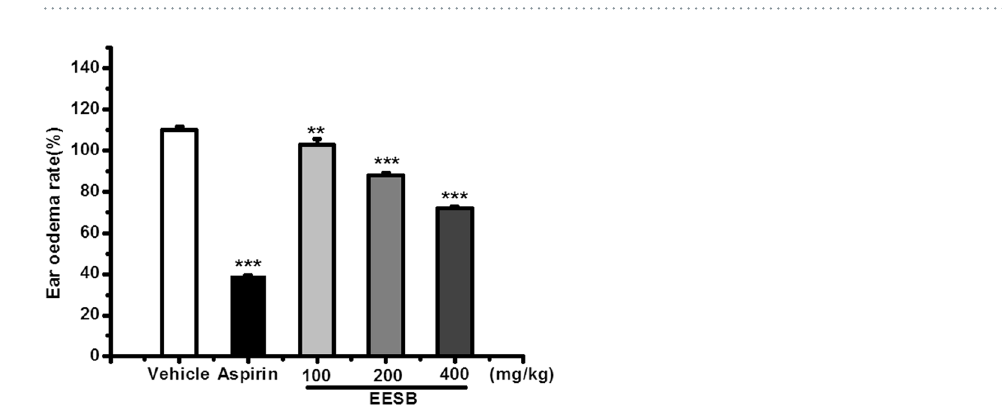
Figure 5. Analgesic effects of YM 11 (5 mg/kg, 10 mg/kg, 20 mg/kg) at 15, 30 and 60 min after injection, as assessed by hot plate test. Results are expressed as mean ± SEM (n = 10). * P < 0.05 vs . vehicle and experimental groups at each time.